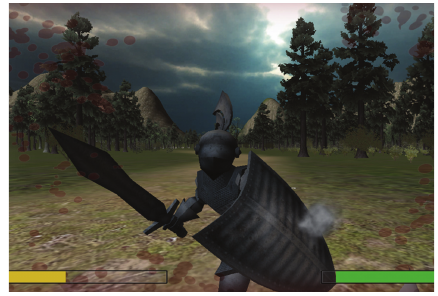
Figure 1: A screen snapshot from the sword